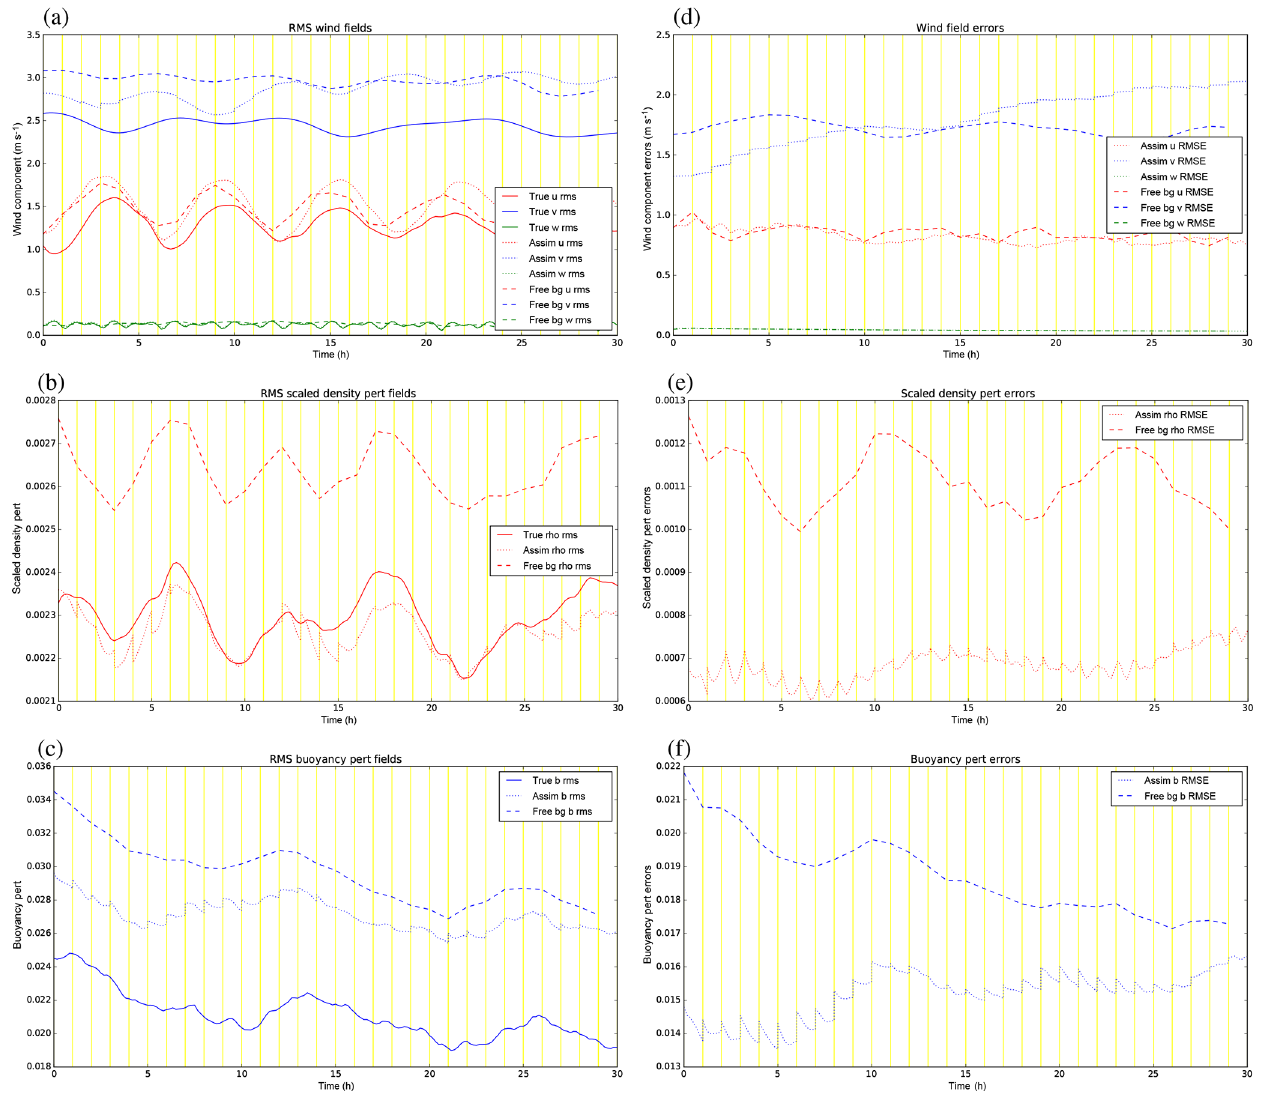
Figure 13. As Fig. 11 but for experiment GB + VR −